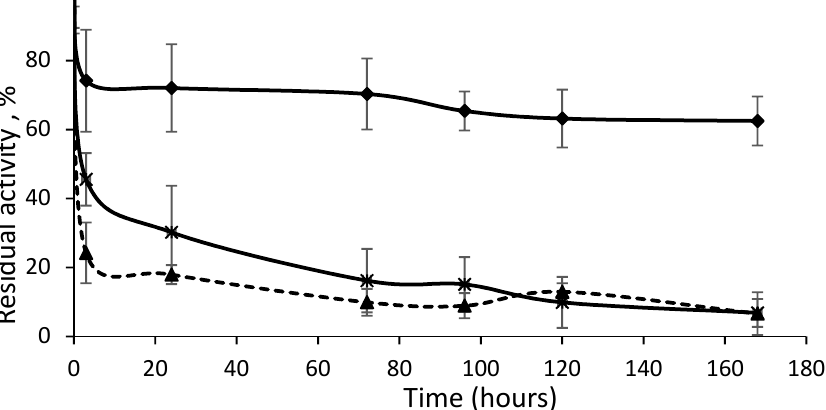
Figure 7. Time course of thermal inactivation of three Lecitase derivatives. Rhombus: bimolecular aggregate of open enzyme covalently immobilized; triangles: closed enzyme covalently immobilized; crosses: open enzyme adsorbed onto oc- tyl-agarose.